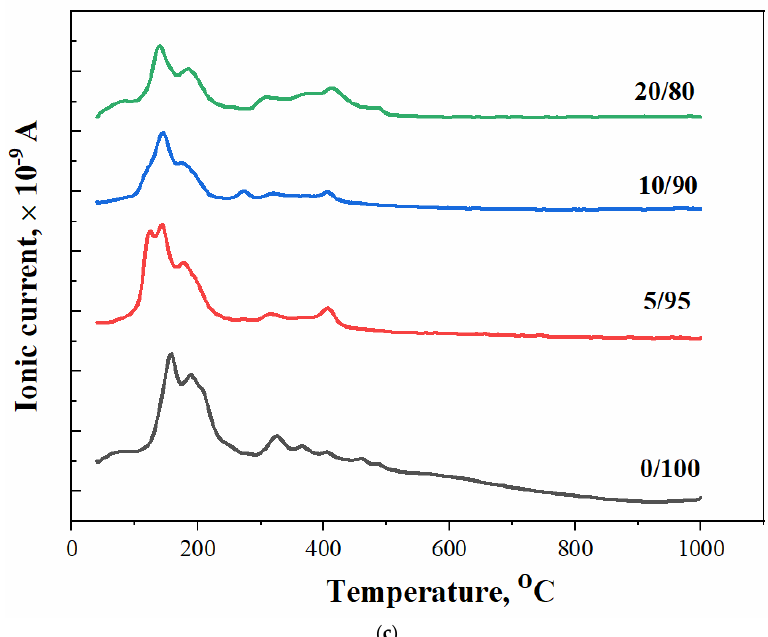
Figure 6. The thermal analysis of synthesized brushite powders from calcium citrate and MCPM: ( a ) powder mass versus temperature upon heating; ( b , c ) ion current curves according to mass spectroscopy for m/Z = 18 (H 2 O) ( b ) and for m/Z = 44 (CO 2 ) ( c ), respectively. Thermal decomposition of calcium citrate tetrahydrate Ca 3 (C 6 H 5 O 7 ) 2 ·4H 2 O of the samples in the air is sequentially realized by the following reactions [27]: